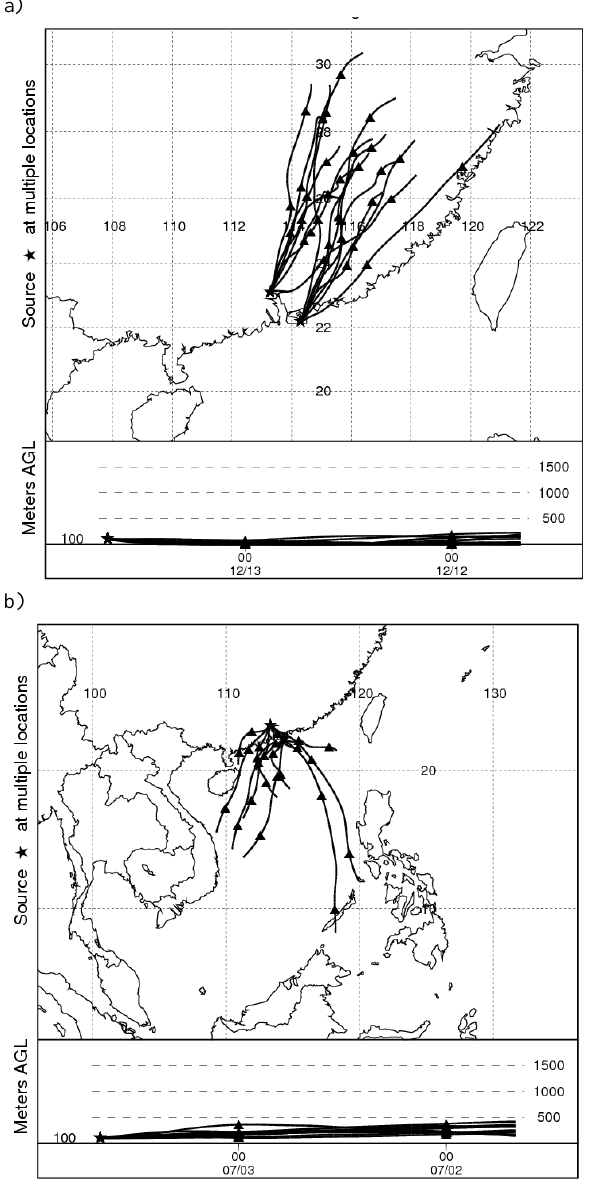
Fig. 2. 2-day air mass back trajectories in winter (a) and in summer (b) during the sampling period.